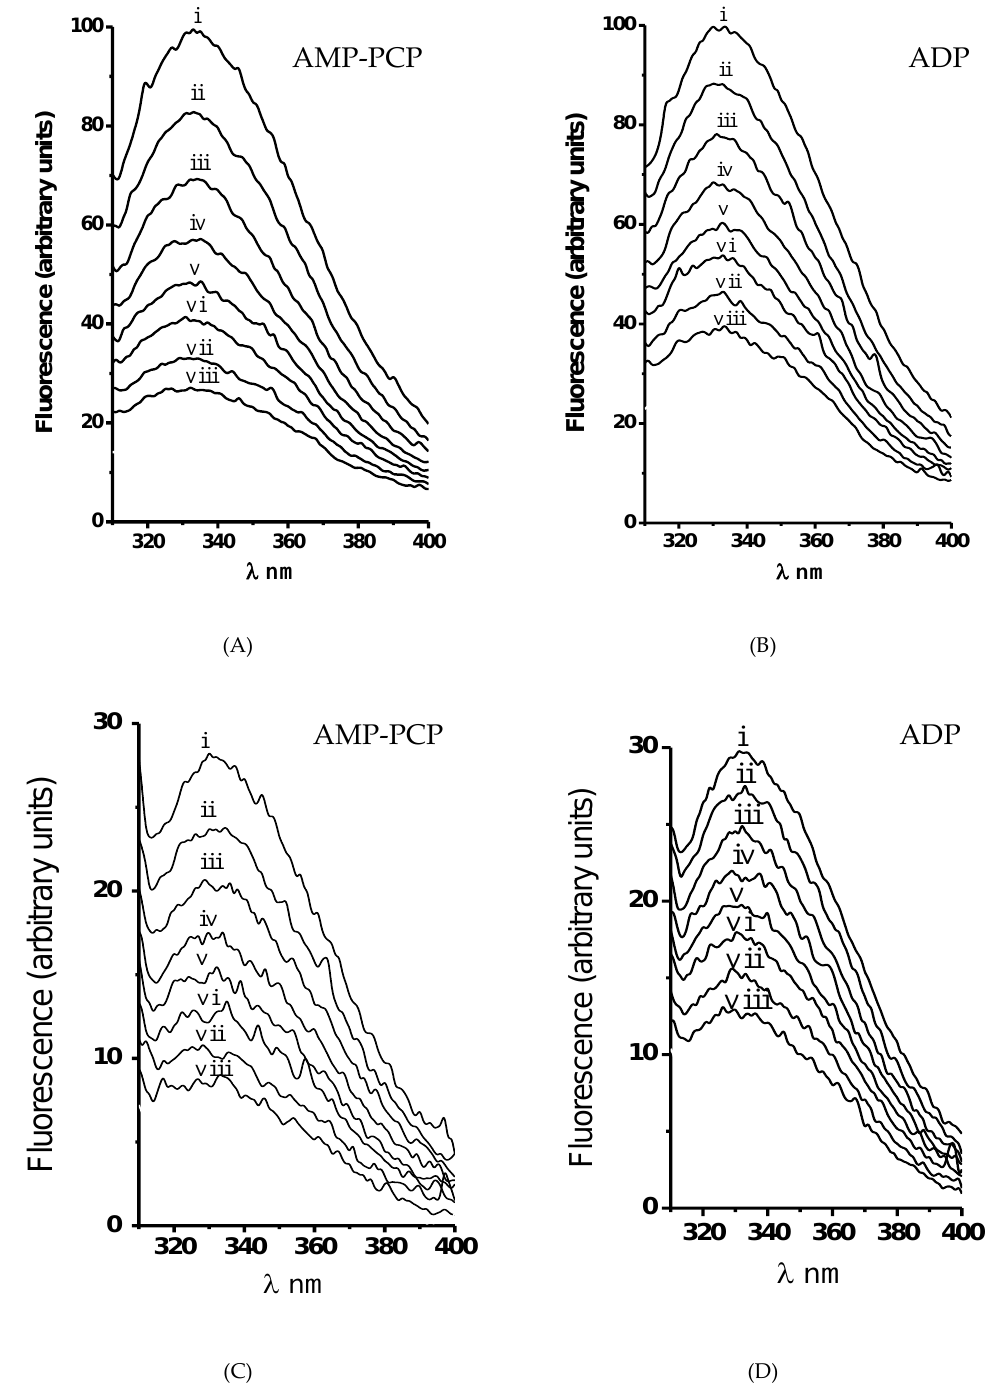
Figure 8. Nucleotide binding-mediated intrinsic fluorescence quenching in the ( A , B ) aggregated and ( C , D ) free H + -ATPase hexamer. Experimental conditions are the same as in Figure 7. The intrinsic fluorescence of H + -ATPase was titrated by nucleotide addition: (A,C) AMP-PCP and (B,D) ADP. Nucleotide concentration ( µ M): (i) none, (ii) 25, (iii) 50, (iv) 75, (v) 100, (vi) 125, (vii) 160, and (viii) 200. The fluorescence spectrum of H + -ATPase was recorded by excitation at a wavelength ( λ ) of 295 nm. Each experiment was performed three times; the spectra displayed are from a representative